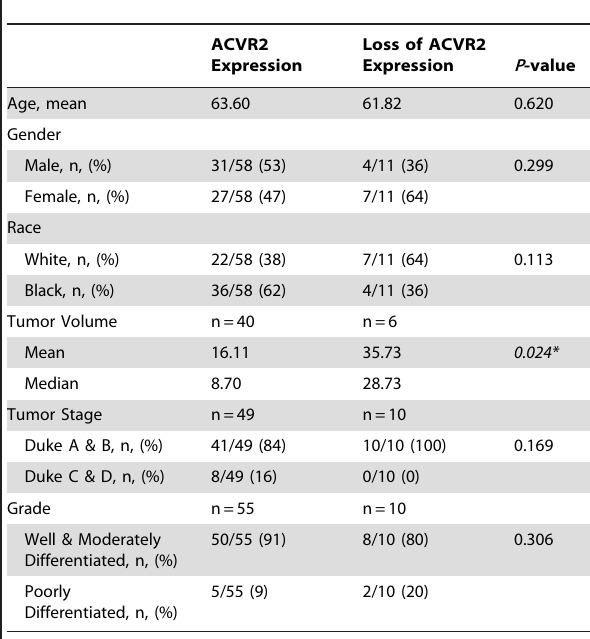
Table 4. Loss of ACVR2 expression is associated with larger tumor